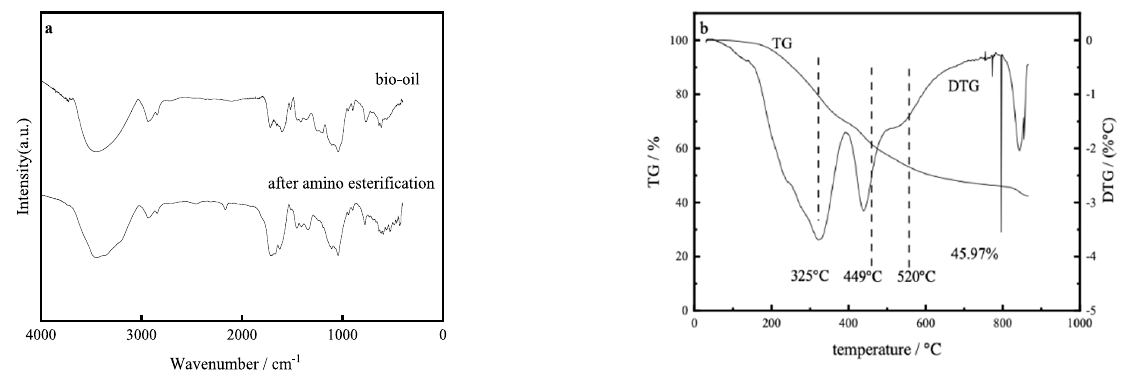
Figure 1. ( a ) IR spectra of bio-oil before and after carbamate; ( b ) TG-DTG curves of bio-phenolic resins.